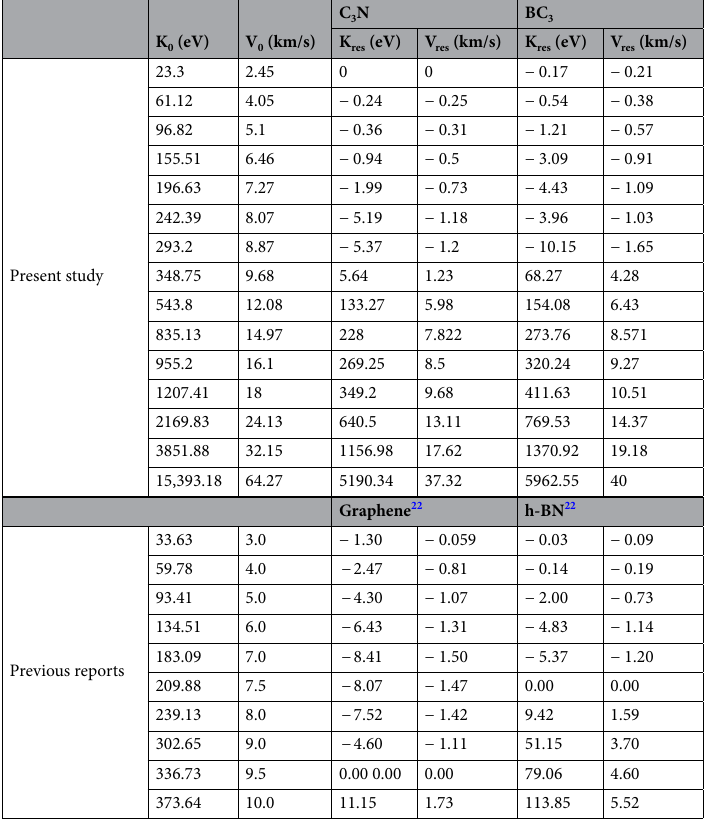
Table 2. Comparison of residual kinetic energy (K res ) and velocity (V res ) of monolayer C3N, BC3 using molecular dynamics simulations (present study) and K res and V res of graphene, h-BN using DFT and FEM (previous reports).